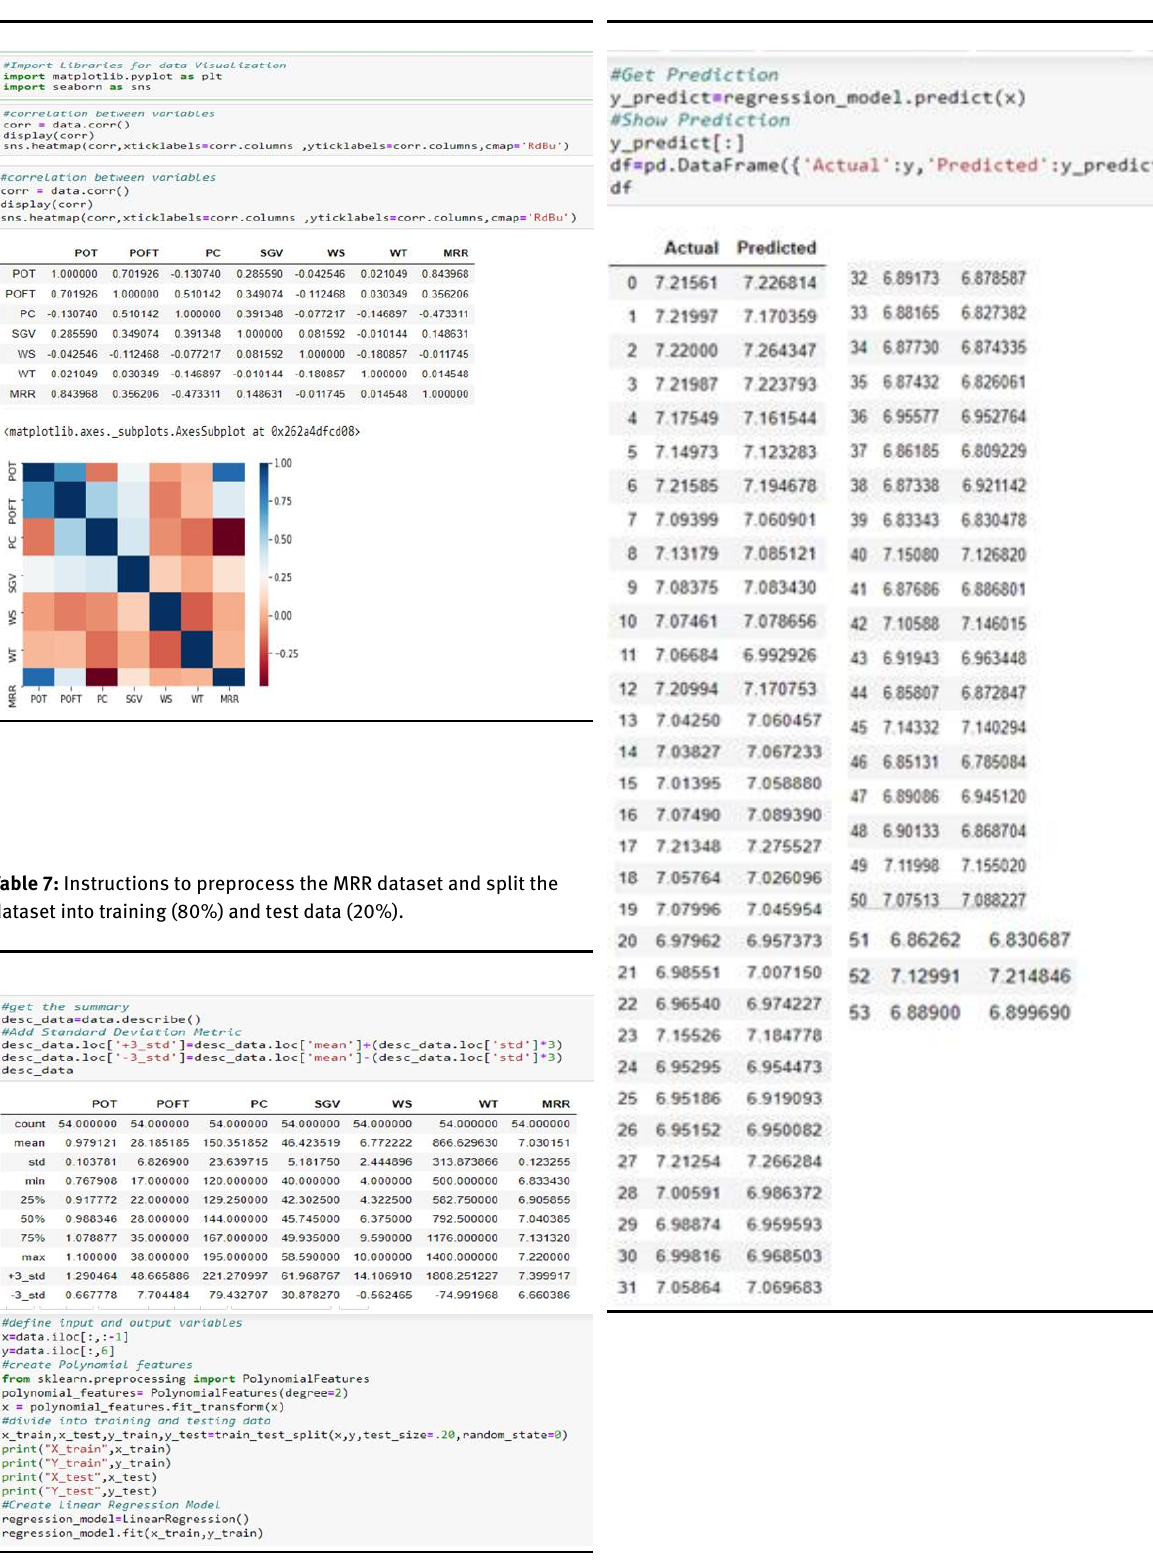
Table 6: Co-relation matrix and heat map for MRR.